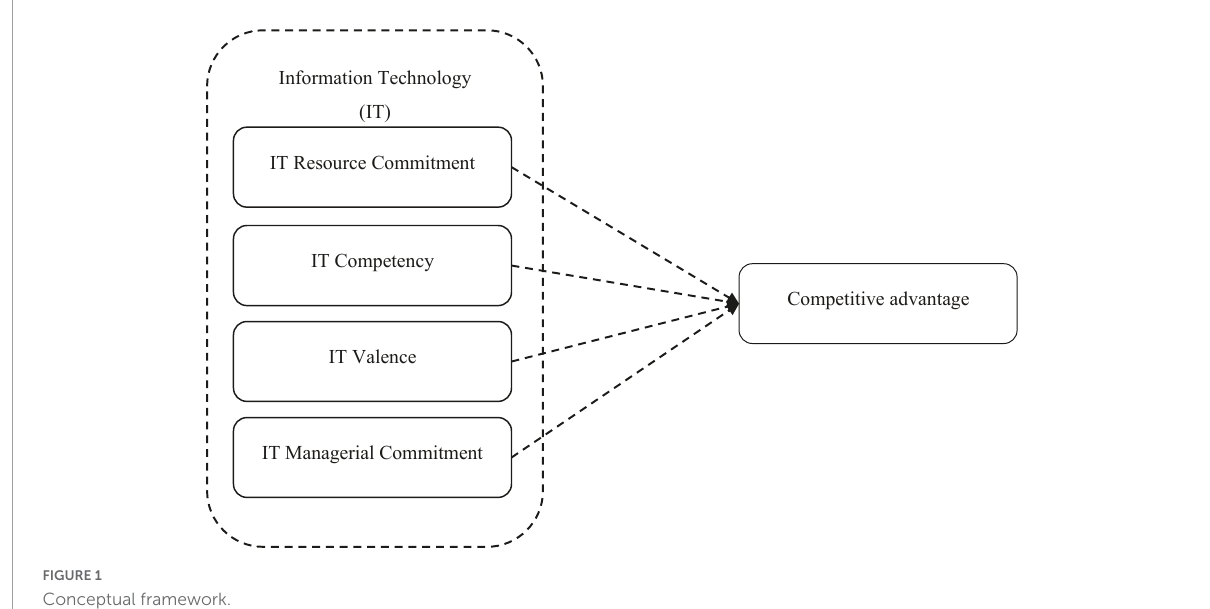
FIGURE1 Conceptual